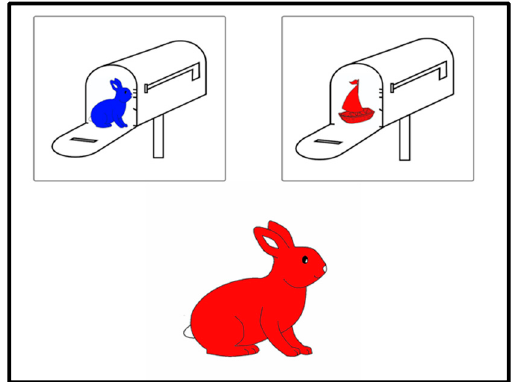
Figure 1. Example of the stimuli used for the Dimensional Change Card Sort test. Top: pictures of the two letter-boxes; bottom: an example of the stimulus target. ● Flanker test (F, modified from Eriksen and Eriksen [80])